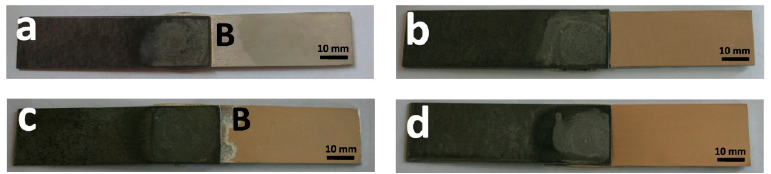
Figure 5. Solder joint appearance of VDW: ( a ) AZ31/DP600; ( b ) AZ31/non-zinc-coated DP600; ( c ) Mg/DP600; ( d ) Mg/non-zinc-coated DP600.